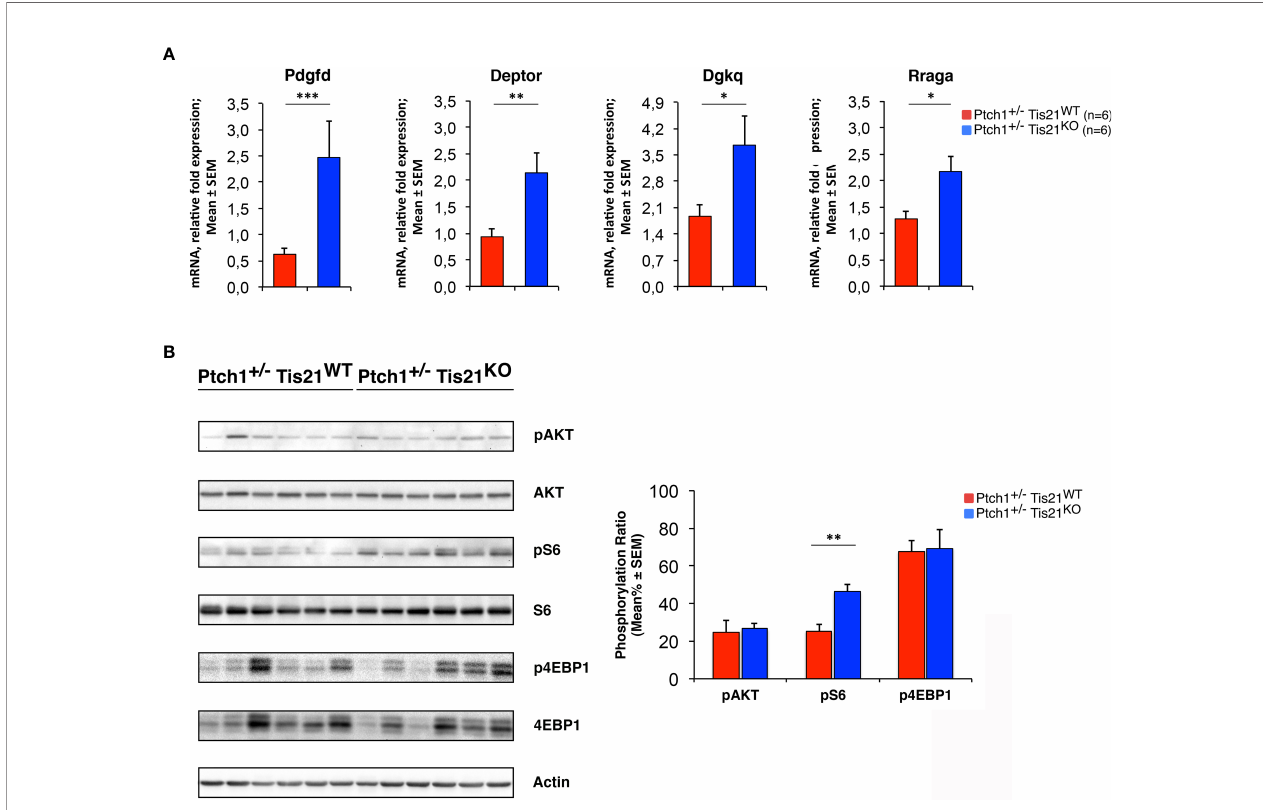
FIGURE 3 | The Ptch1 +/ − /Tis21 KO -speci fi c activation signature of the PI3K/AKT/mTOR pathway is detectable also in adult MBs. (A) The differential expression of four representative Ptch1 +/ − /Tis21 KO -speci fi c genes, identi fi ed by microarray analysis in GCPs at P7 as indicated in Figures 1 and 2 , was observed also in full-blown Ptch1 +/ − /Tis21 KO tumors by real-time PCR, analyzing their mRNA fold expression relative to Ptch1 +/ − /Tis21 WT MBs (one of them chosen for setting to unit). TBP was used to normalize data. Mean ± SEM fold increases are from three independent experiments; six MBs per genotype were analyzed. * p < 0.05, ** p < 0.01, or *** p < 0.001, Student ’ s t test. (B) Protein extracts from Ptch1 +/ − /Tis21 WT ( n = 6) and Ptch1 +/ − /Tis21 KO ( n = 6) MBs were subjected to immunoblotting and densitometry analysis using antibodies against phospho-AKT (at Ser473), AKT, phospho-S6 (at Ser235/236), S6, phospho-4EBP1 (at Thr37/46), and 4EBP1. Densitometric data of protein phosphorylation, expressed as mean% ± SEM, were calculated by averaging the band intensity value of phosphorylated protein versus the densitometric value of total protein of each sample. ** p < 0.01, Student ’ s t